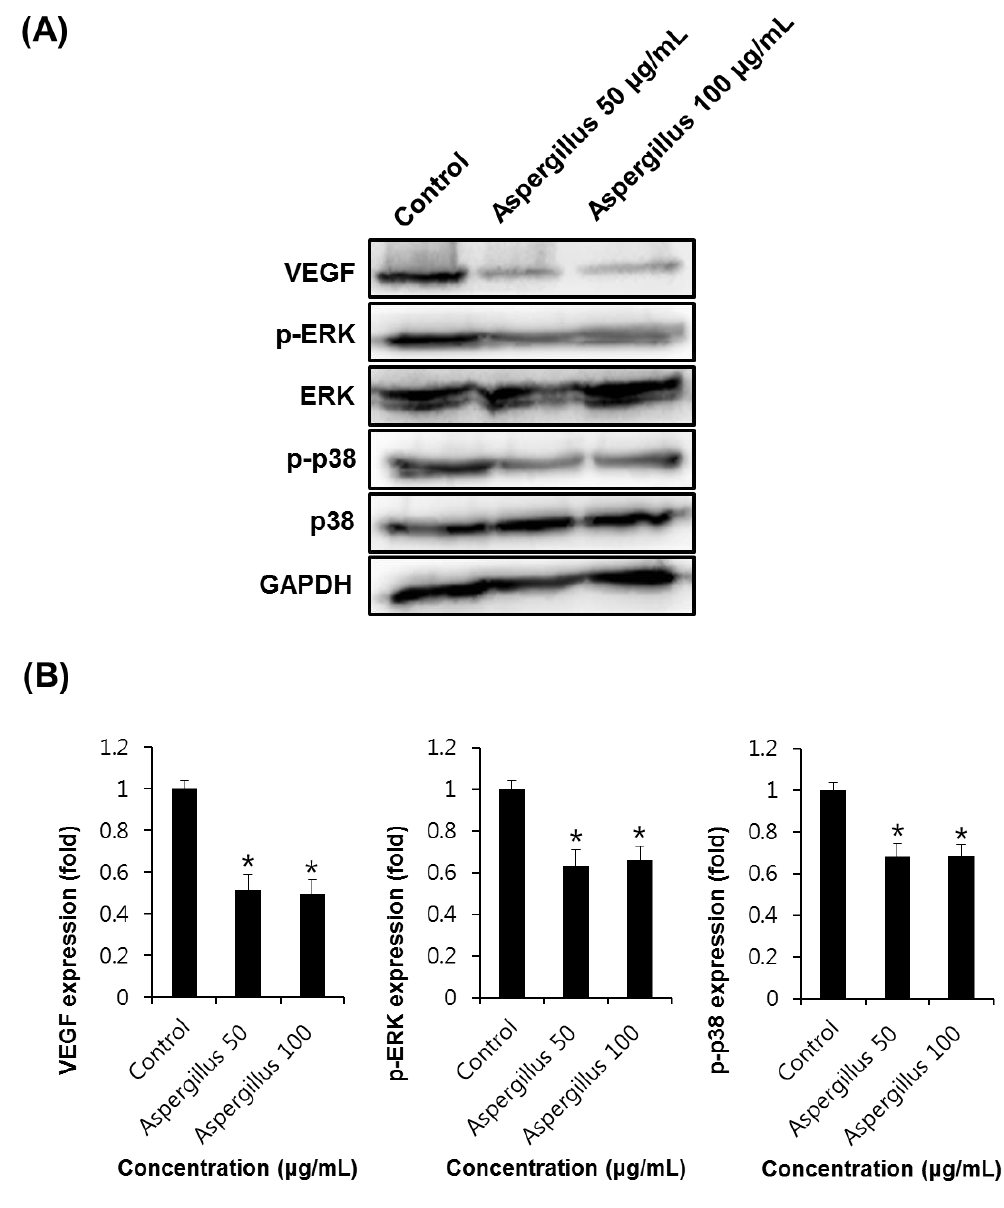
Figure 5. The effect of Aspergillus extract on angiogenic protein expression in HUVECs. (A) Western blot showing the levels of VEGF (21 kDa), phosphorylated ERK (42/44 kDa), ERK (42/44 kDa), phosphorylated p38 (38 kDa), and p38 (38 kDa) in HUVECs treated with Aspergillus extract at different concentrations for 24 h. (B) Graphs indicating quantification of the effect of Aspergillus extract on the angiogenic protein expression in HUVECs. Data are expressed as mean ± SEM. Similar results were obtained in three independent experiments; * p < 0.05 compared to the control value.